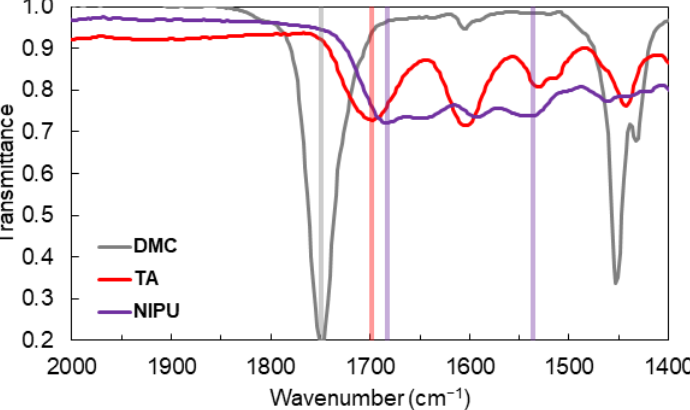
Figure 1. Two-step NIPU synthesis: ( Step 1 ) the carbonation of tannic acid with dimethyl carbonate, resulting in mono-, di-, or tri-substitution and ( Step 2 ) the formation of a single urethane, shown here with monosubstitution.